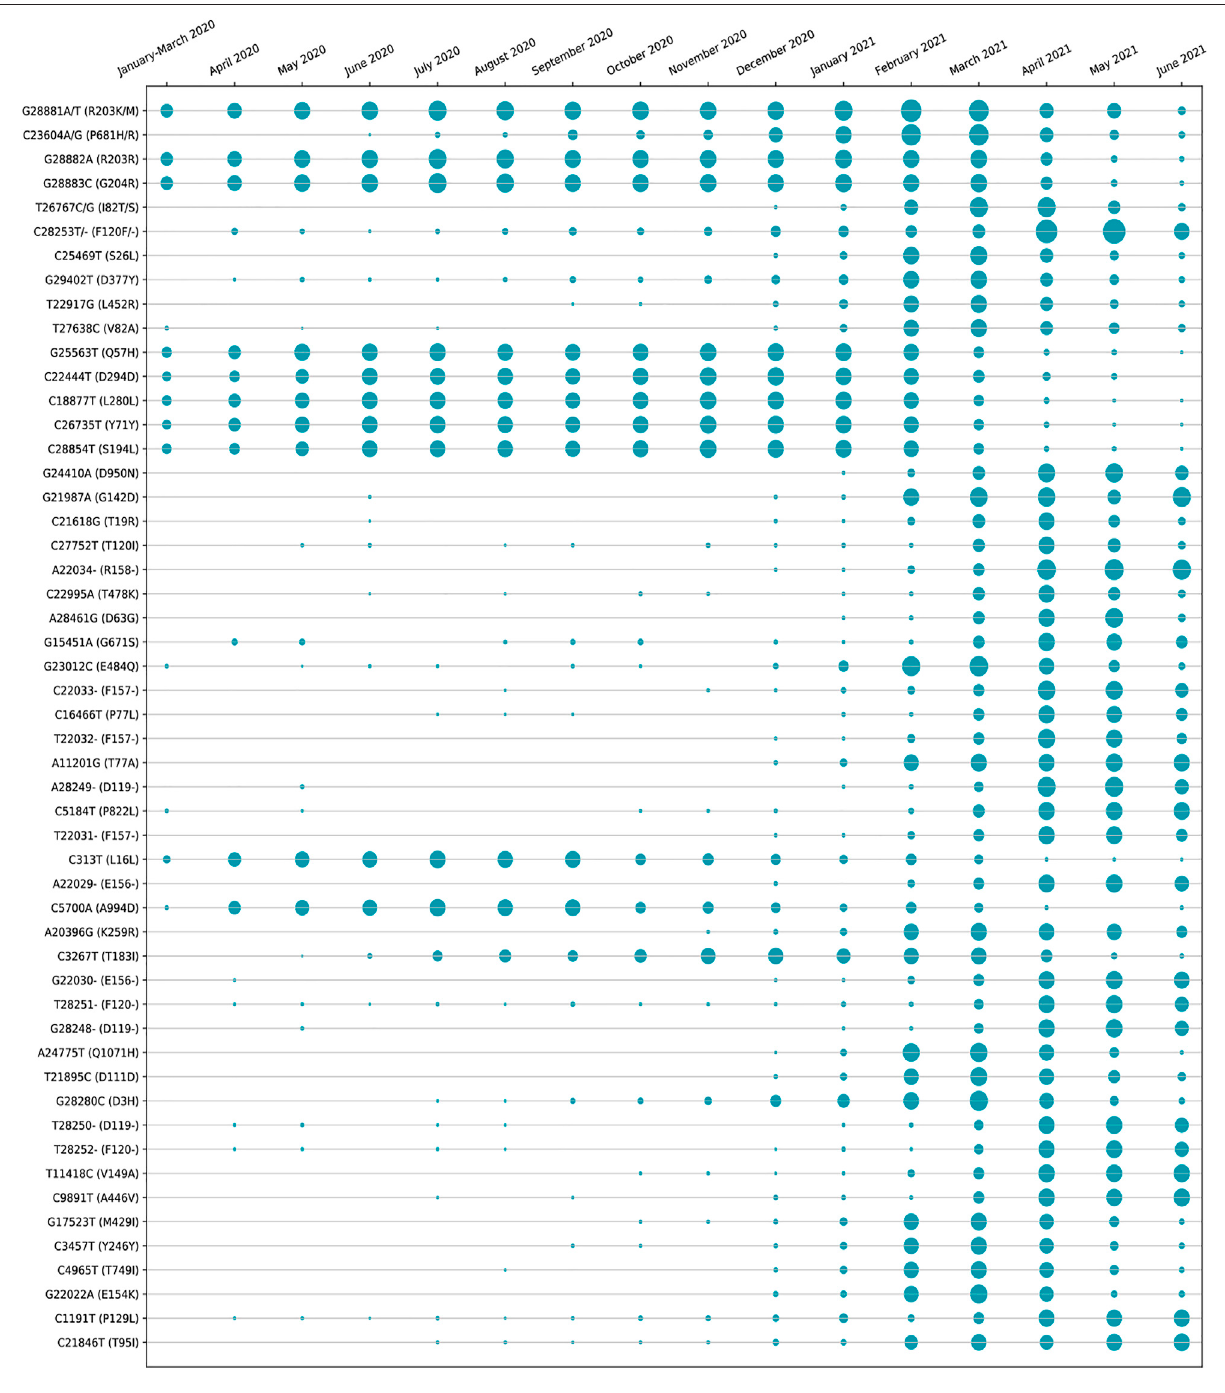
Frontiers in Genetics |